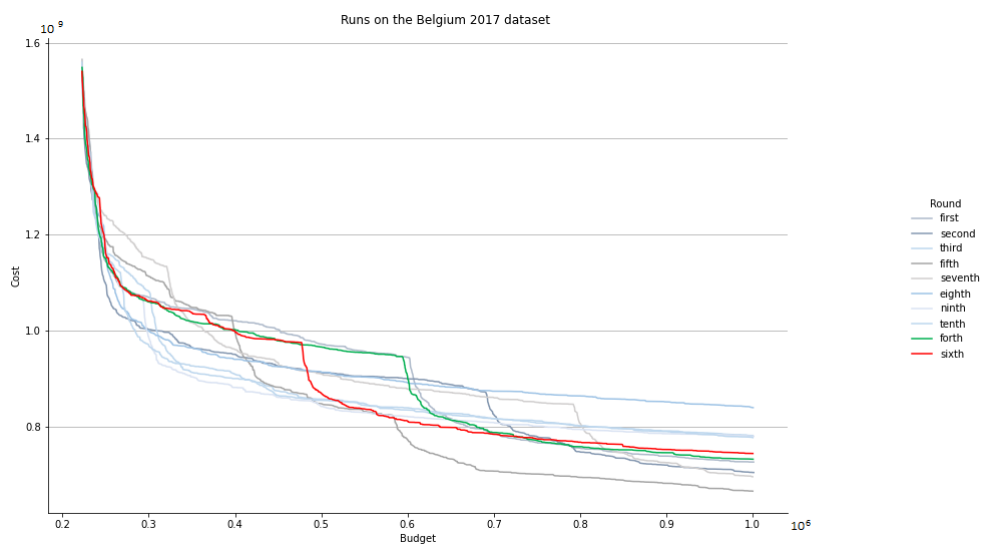
Figure 17. All 10 runs on Belgium 2017 dataset.